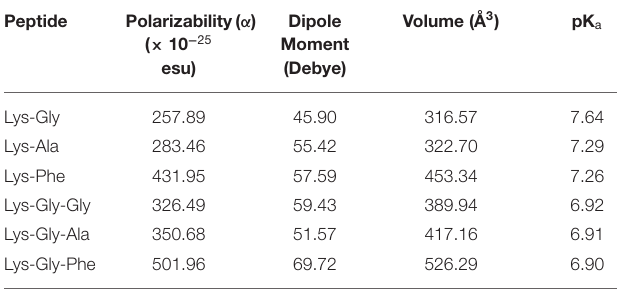
TABLE 1 | Calculated physicochemical properties of the peptides.